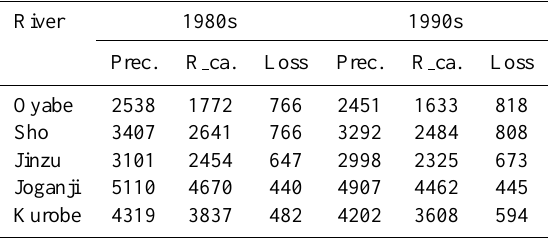
Table 5. Simulated basin average precipitation (Prec.), runoff (R ca.) and their different (Loss) for the five river basins in the 1980s and 1990s (unit: